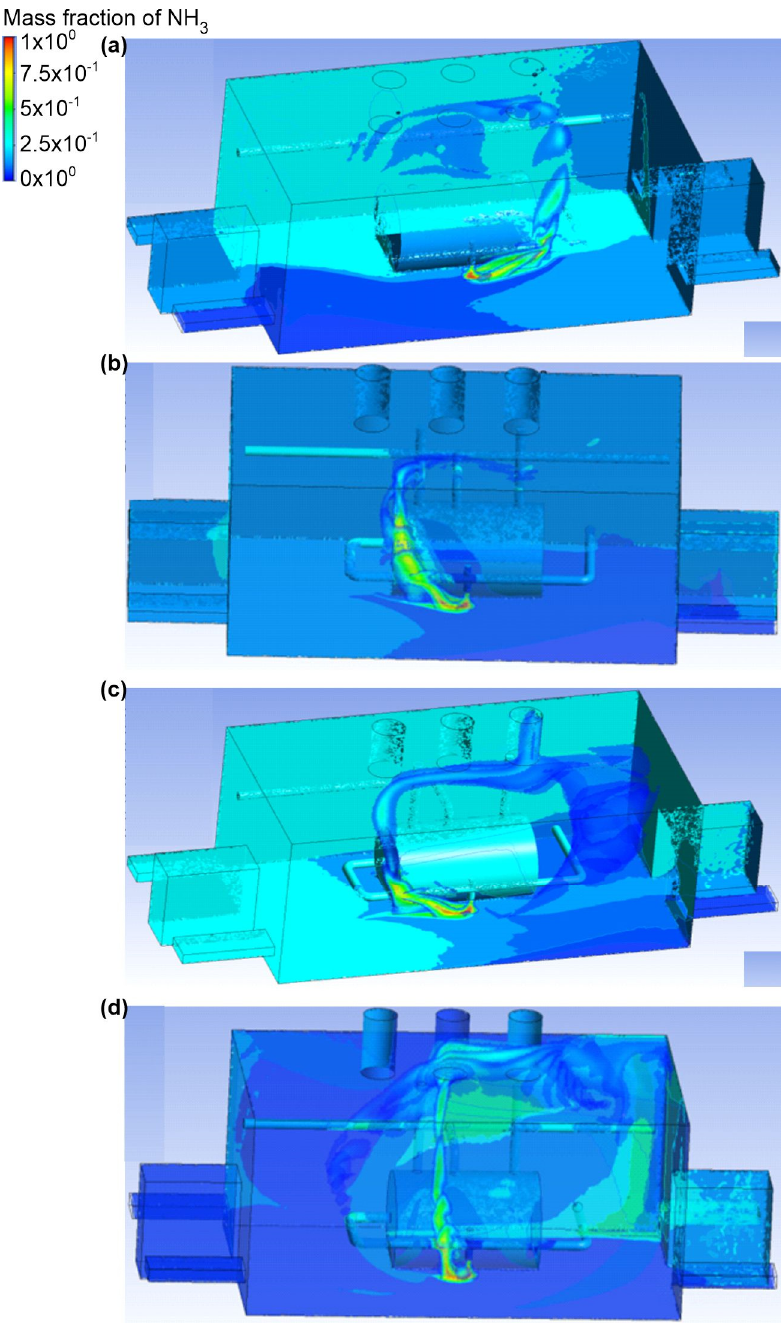
Figure 14. Ammonia distribution in the engine room for: ( a ) scenario A, ( b ) scenario B, ( c ) scenario C, and ( d ) scenario D.